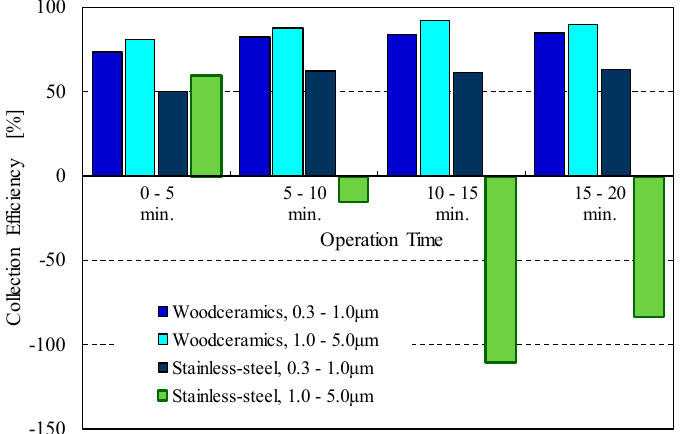
Figure 12. Particle-collection efficiencies over time for various electrode types and particle size ranges. With the woodceramics electrode, the collection efficiency for large particles remained high while that with the stainless-steel electrode decreased with the operating time.